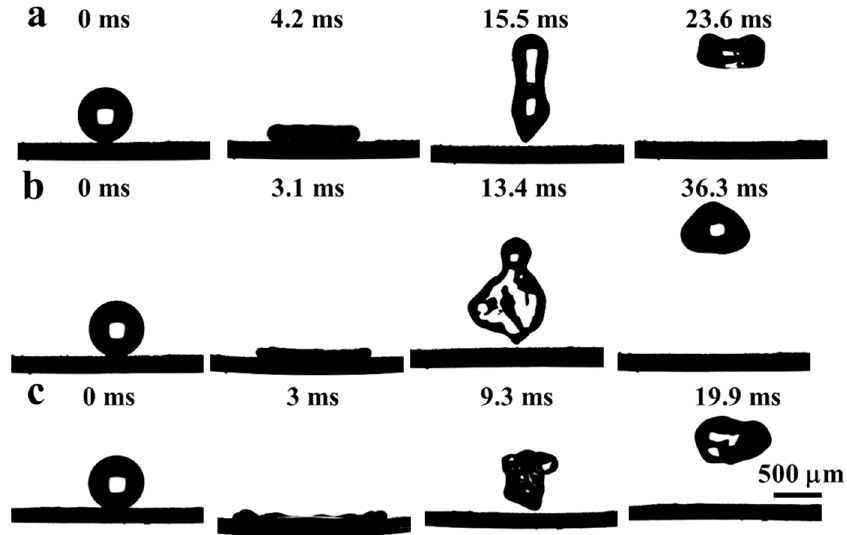
Figure 7. Droplet impacting the elastic cold superhydrophobic membrane surface with stiffness k ~ 0.65 N/m at impacting speed of ( a ) 0.6 m/s; ( b ) 0.9 m/s; and ( c ) 1.8 m/s.